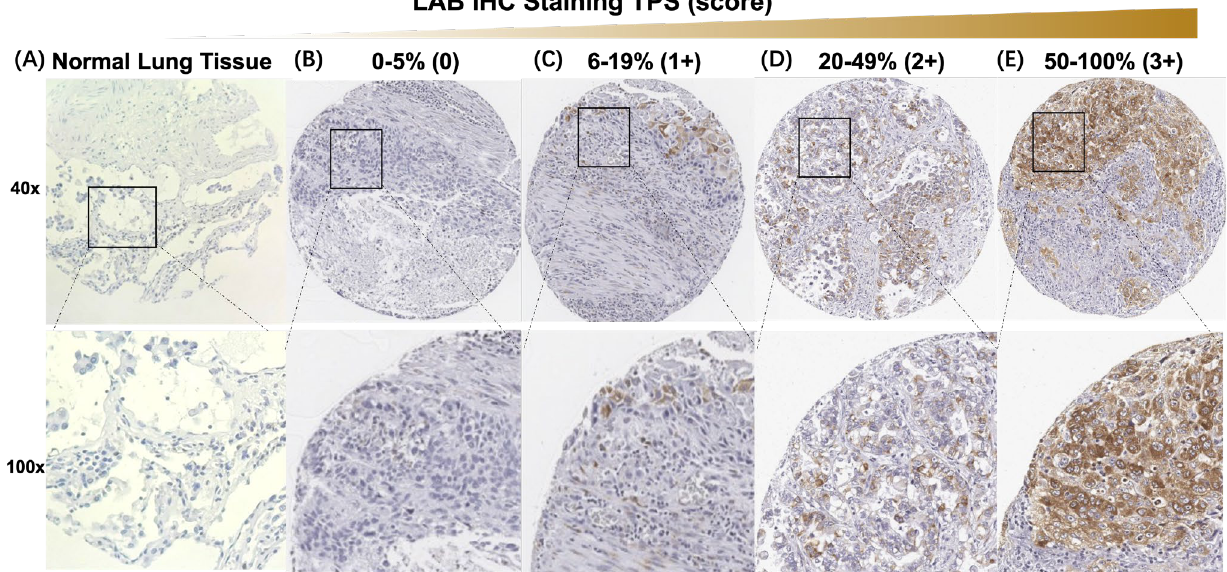
Figure 2. Atlas of LAB expression by IHC. ( A ) Representative pictures of LAB stain in normal lung tissue. ( B – E ) Atlas of representative pictures of 0, 1, 2, and 3 IHC scores for LAB expression in NSCLC TMAs. Abbreviations: LAB, labyrinthin; IHC, immunohistochemistry; NSCLC, non-small-cell lung cancer; TMA, tissue microarray; TPS, tumor proportion score.